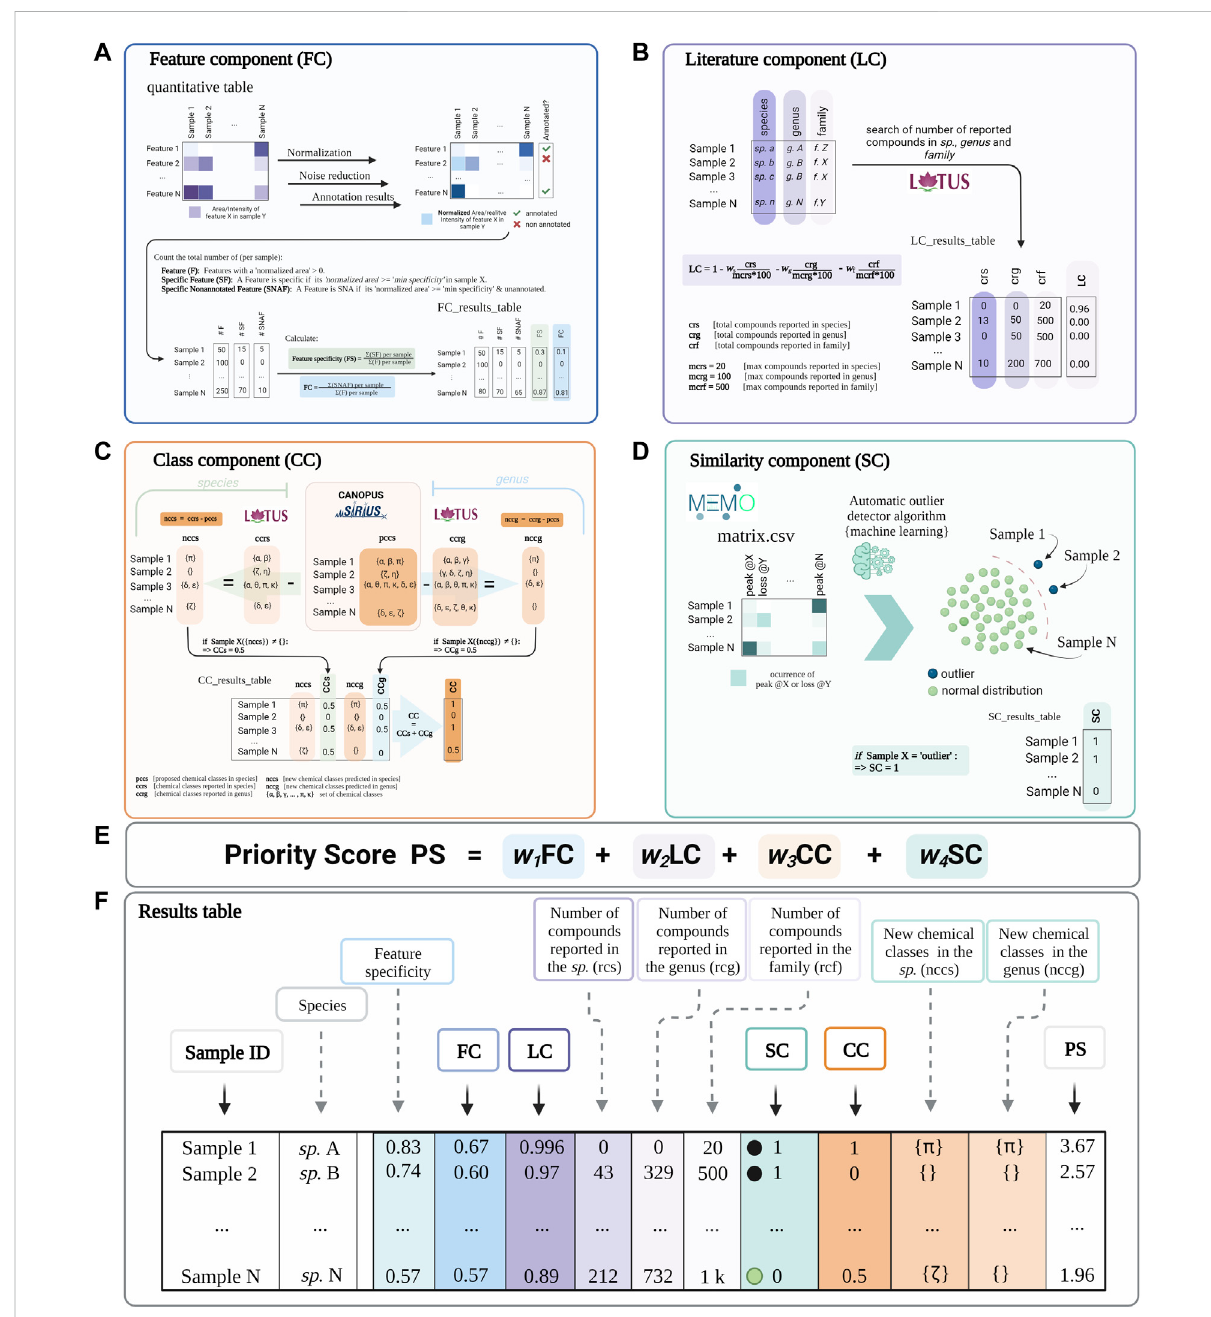
FIGURE 1 A conceptual overview of Inventa ’ s priority score and its components. (A) Feature Component (FC): is a ratio of the number of speci fi c and unannotated features over the total number of features by extract. (B) Literature Component (LC): is a score based on the number of compounds reported in the literature for the taxon. It is independent of the spectral data. (C) Class Component (CC): indicates if an unreported chemical class is detectedineachextractcomparedtothosereportedinthespeciesandthegenus. (D) SimilarityComponent(SC):Comparesextractsbasedon their general MS 2 spectral information though their MEMO vectors and automatic outlier detectors. This score is independent from any retention- time based alignment procedure and complementary to FC. (E) The Priority Score (PS) is the addition of the four components. A modulating factor ( w n ) gives each component a relative weight according to the user ’ s preferences. The higher the value, the higher the rank of the extract. (F) Results Table is a resume of individual calculation components and